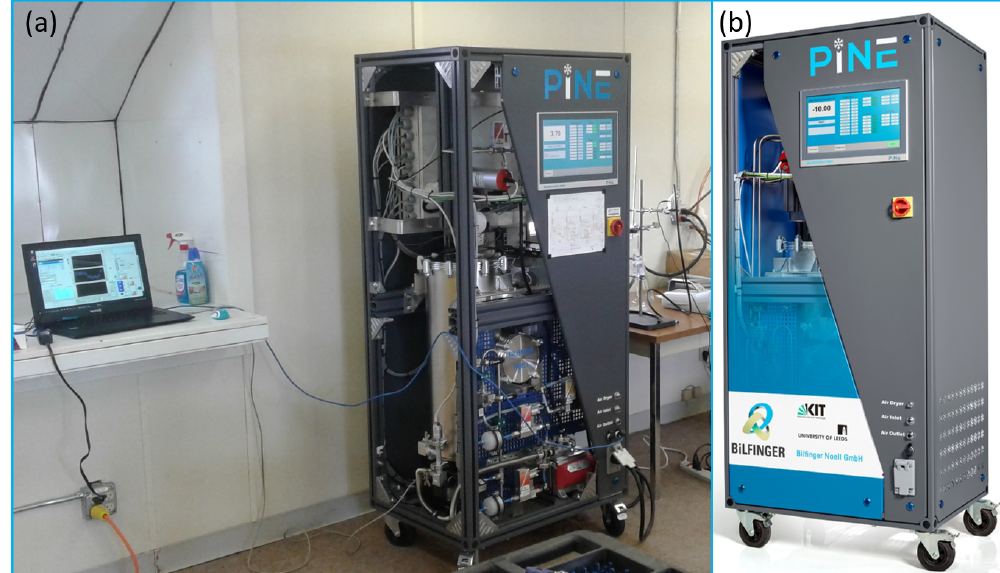
Figure A7. Photograph of PINE-c (a) located at the ARM-SGP site in Oklahoma for continuous INP measurements for 45 days from 1 October to 14 November 2019. Panel (b) shows a composite photograph of the same instrument before delivery.